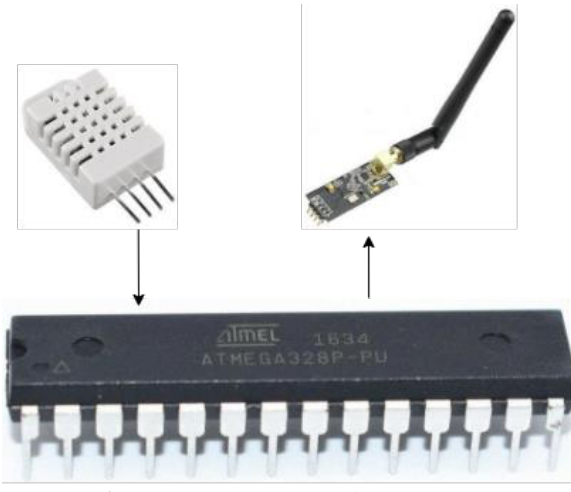
Figure 2.1 . Block diagram of these modules.